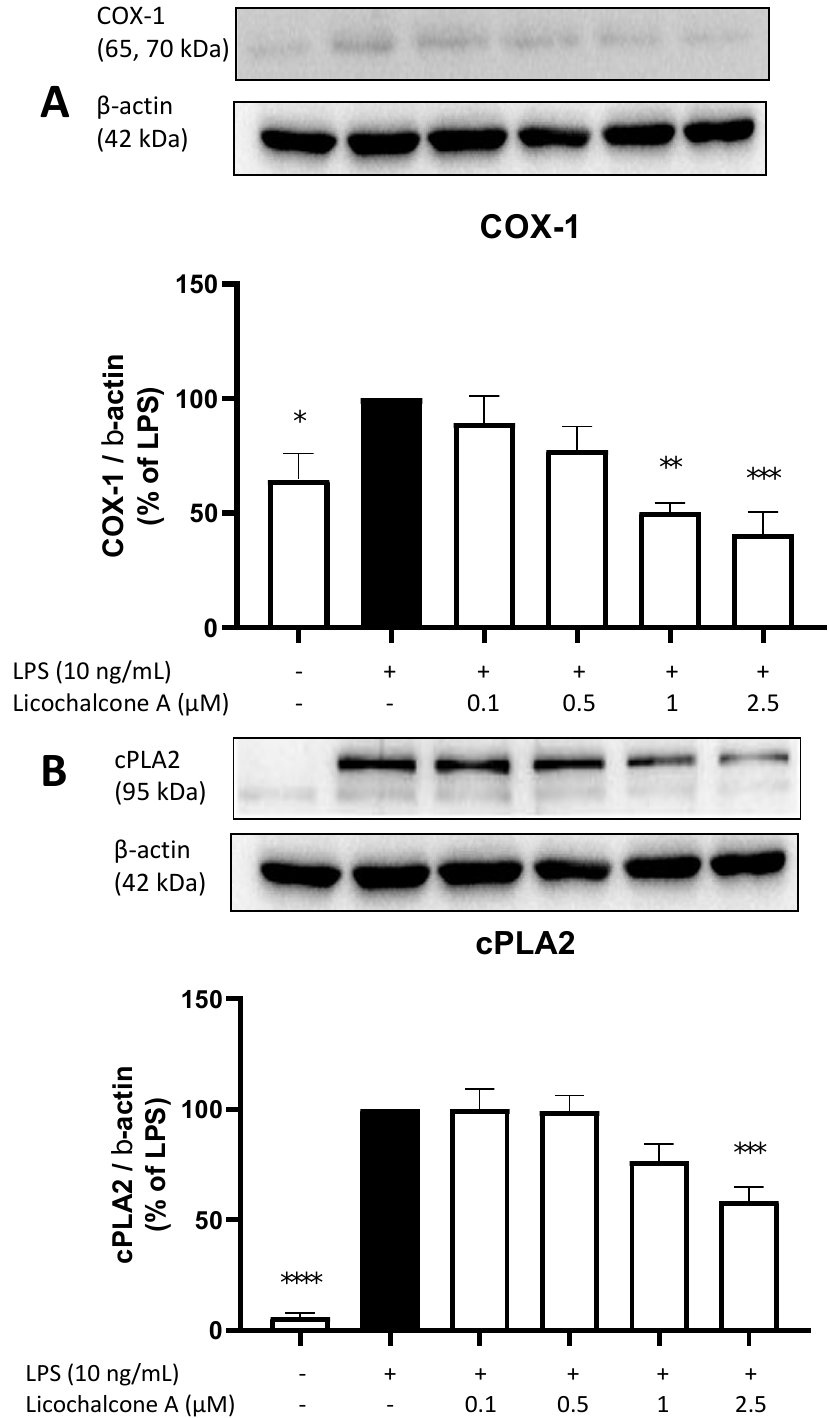
Figure 4. Effects of Licochalcone A on COX-1 ( A ) and cPLA2 ( B ) synthesis in LPS-stimulated primary rat microglial cells. Cells were stimulated and Western Blot performed as described under materials and methods. Values are presented as the mean ± SEM of at least three independent experiments. Statistical analysis was performed using one-way ANOVA with Dunnett’s post hoc tests with * p < 0.05, ** p < 0.01, *** p < 0.001, and **** p < 0.0001 compared to LPS stimulated cells.